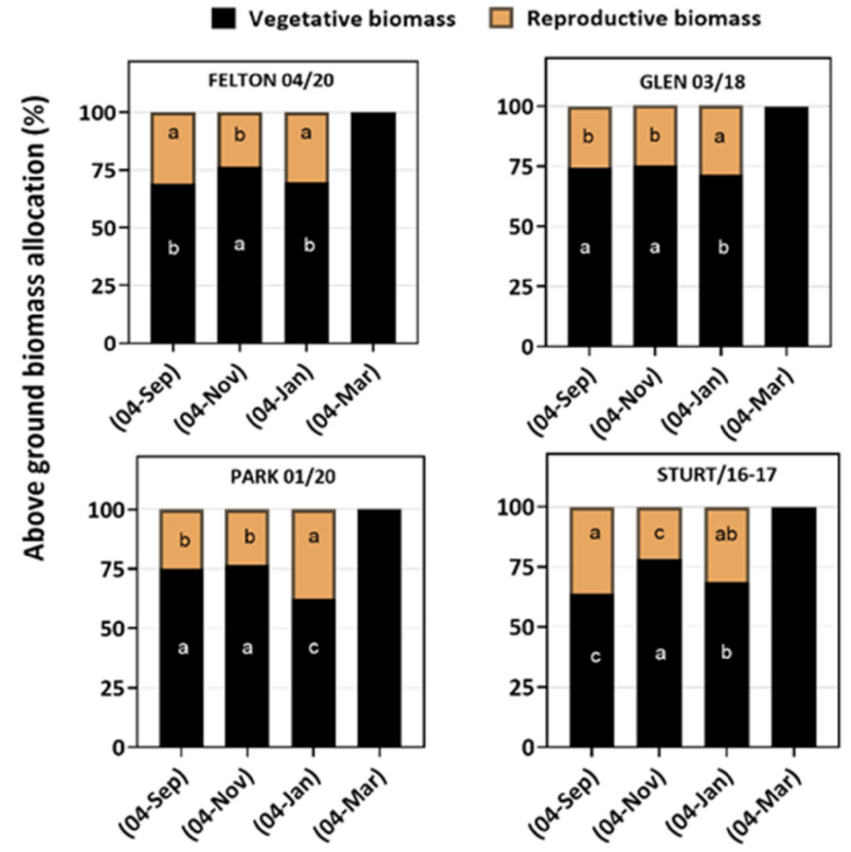
Figure 3. The biomass allocation (% of total biomass) of four feathertop Rhodes grass populations at four sowing times. The early-autumn cohort (4 March) had only vegetative growth because of cold winter conditions. Different letters for the same developmental period indicate significant differences with 5% level of